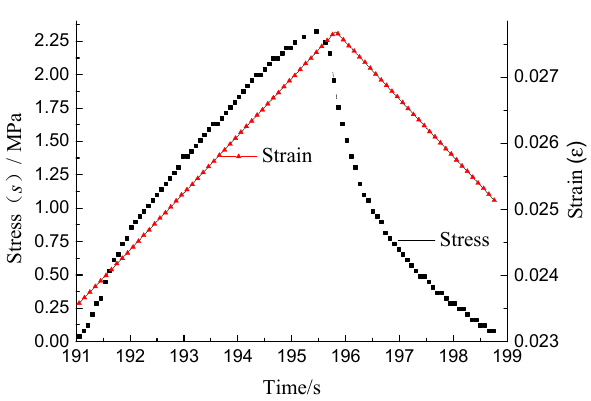
Figure 1. Stress-strain curve.